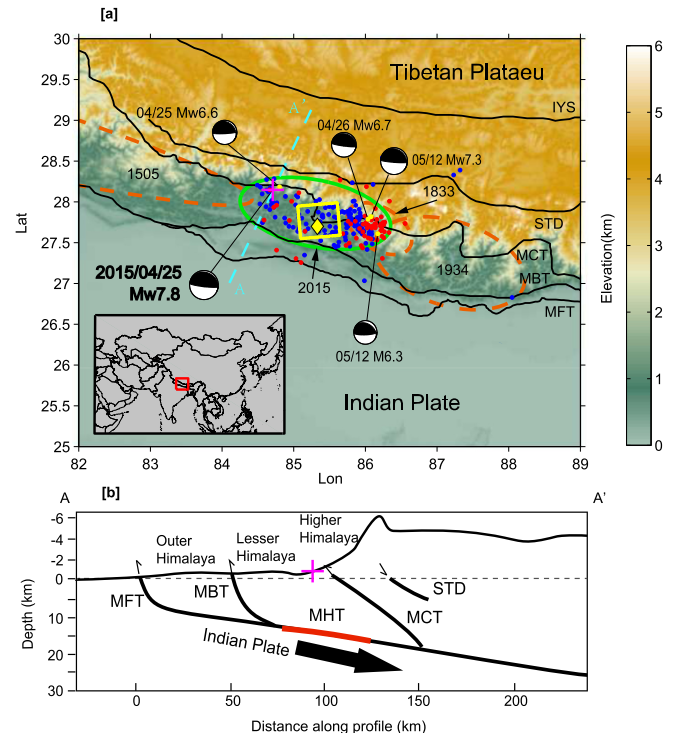
Figure 1. Seismo-tectonic setting of the Himalayan region (modified with permission from [27]) ( a ) tectonic setting of the Himalayan Region with topography. MFT = Main Frontal Thrust, MBT = Main Boundary Thrust, MCT = Main Central Thrust, STD = Southern Tibetan Detachment System, IYS = Indus–Yarlung Suture. The purple cross is the epicentre of the main shock and yellow dots are large aftershocks. Focal mechanisms are shown by black and white beach balls. The blue and red dots are aftershocks (Mw > 3.5 that occurred between the mainshock (25 April 2015) and the largest aftershock Mw 7.3 (12 May 2015), and after the largest aftershock till 30 May 2015, respectively. The brown ellipses show rupture areas of the past 1934 (Mw 8.1), the 1833 (Mw 7.6) and the 1505 (Mw 8.2) earthquakes. The green ellipse shows the approximate fault plane of the 2015 Mw 7.8 earthquake. The yellow square is the study area on which this research is performed. ( b ) cross section along AA’ in ( a ) that shows the approximate location of slip of Mw 7.8 earthquake with epicenter location (purple cross) and approximate fault rupture (red line). MHT = Main Himalayan